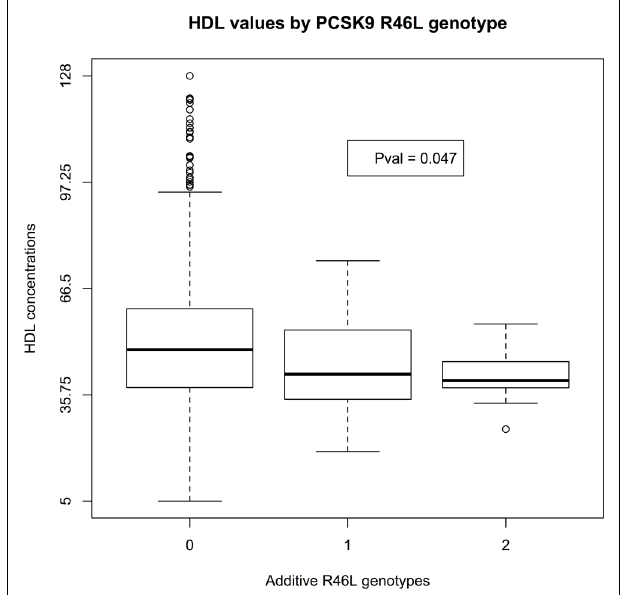
FIGURE 2 | Box and whisker plot of additively encoded PCSK9 R46L genotypes on the X-axis versus age corrected serum HDL concentrations on theY-axis ( n = 1495; min HDL concentration 5; max HDL concentration 128; mean HDL concentration 47). Genotype 0 indicates no copies of the mutant allele, genotype 1 indicates one copy of the mutant allele and genotype 2 indicates 2 copies of the mutant allele.